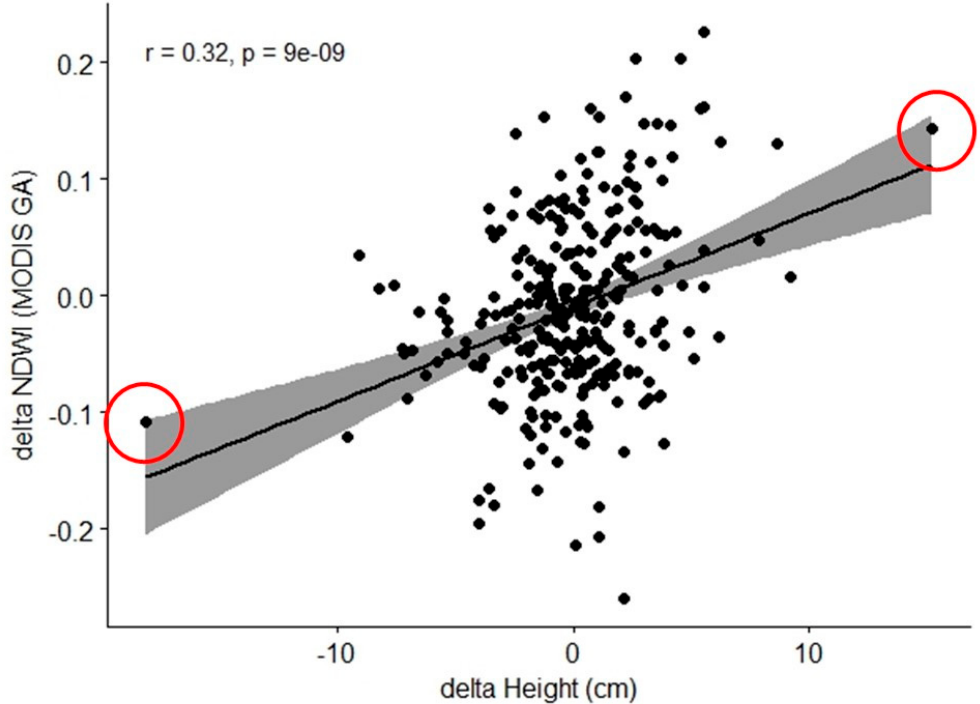
Figure 4. Linear correlation between delta median height and delta NDWI from MODIS GA product, considering the whole field information together. Pearson correlation value and significance are r = 0.32, p < 0.001. The tow influential data points are circled in